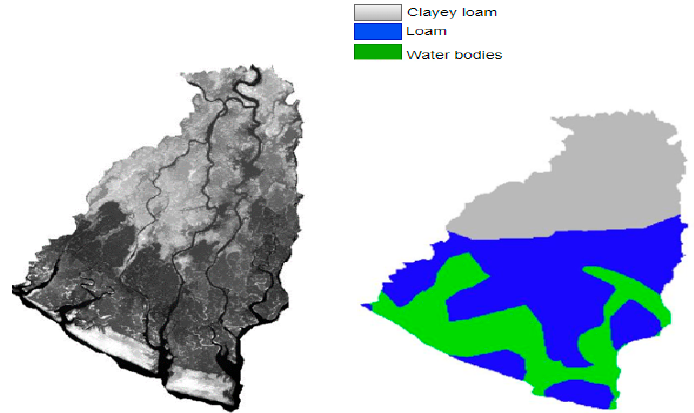
Figure 4. Digital elevation model ( left ) and soil type/cover ( right ) of the study area. Table 5. Data on soil composition. Table 4. Topographical and meteorological data of the study area.